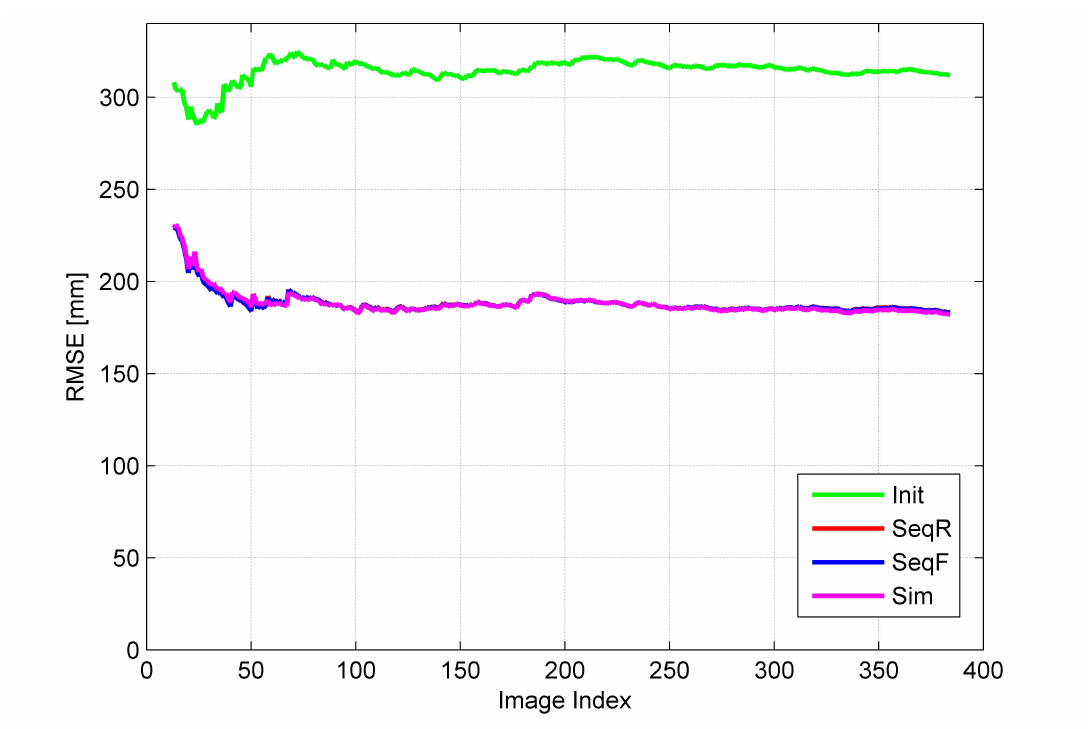
Figure 4. RMSE of estimated EOP